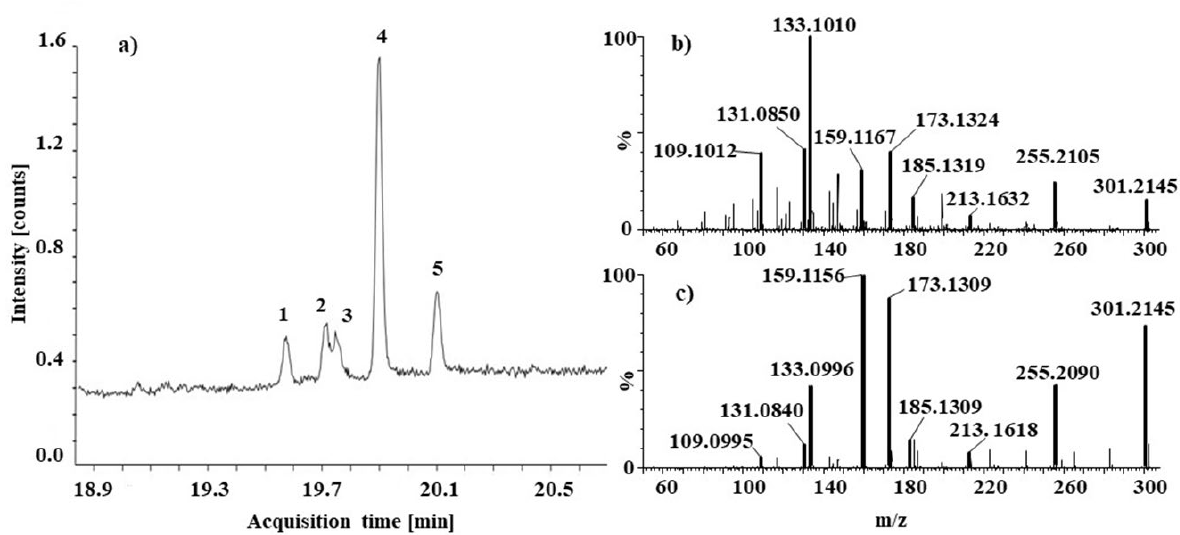
Figure 3. Pyrogram of the pink powder (1: pimaric acid TMS, 2: isopimaric acid TMS, 3: unknown compound, 4: dehydroabietic acid TMS, and 5: abietic acid TMS) ( a ); ASAP IM MS fragmentation spectra of compound m/z 301.2152 in pink powder (collision energy 20 V) ( b ) and in the standard of dehydroabietic acid (collision energy 20 V) ( c ).